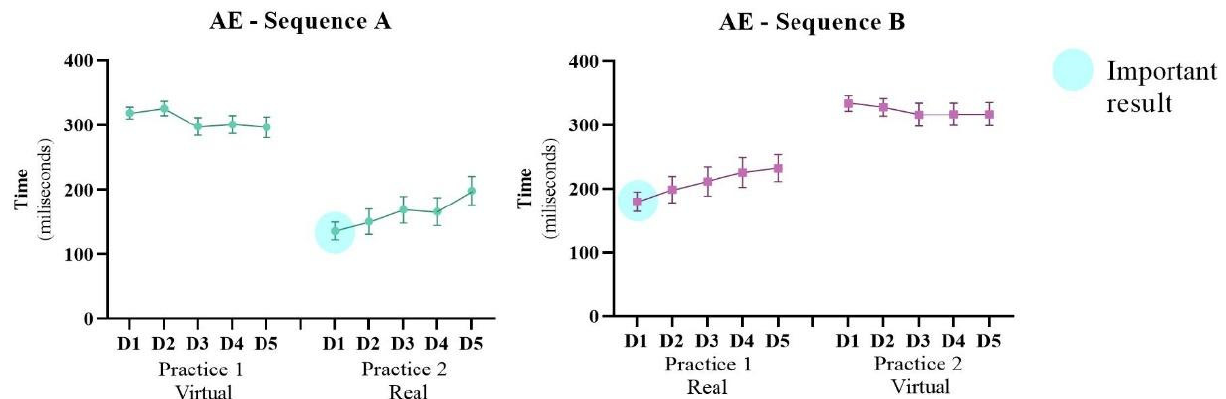
Figure 3. Representation of mean and standard error of the Absolute Error (AE) of both Sequences (A: virtual → real and B: real → virtual) during the 10 days of intervention (D1–D5: Days of intervention). ● Important result: The participants that practiced fi rst in the virtual interface